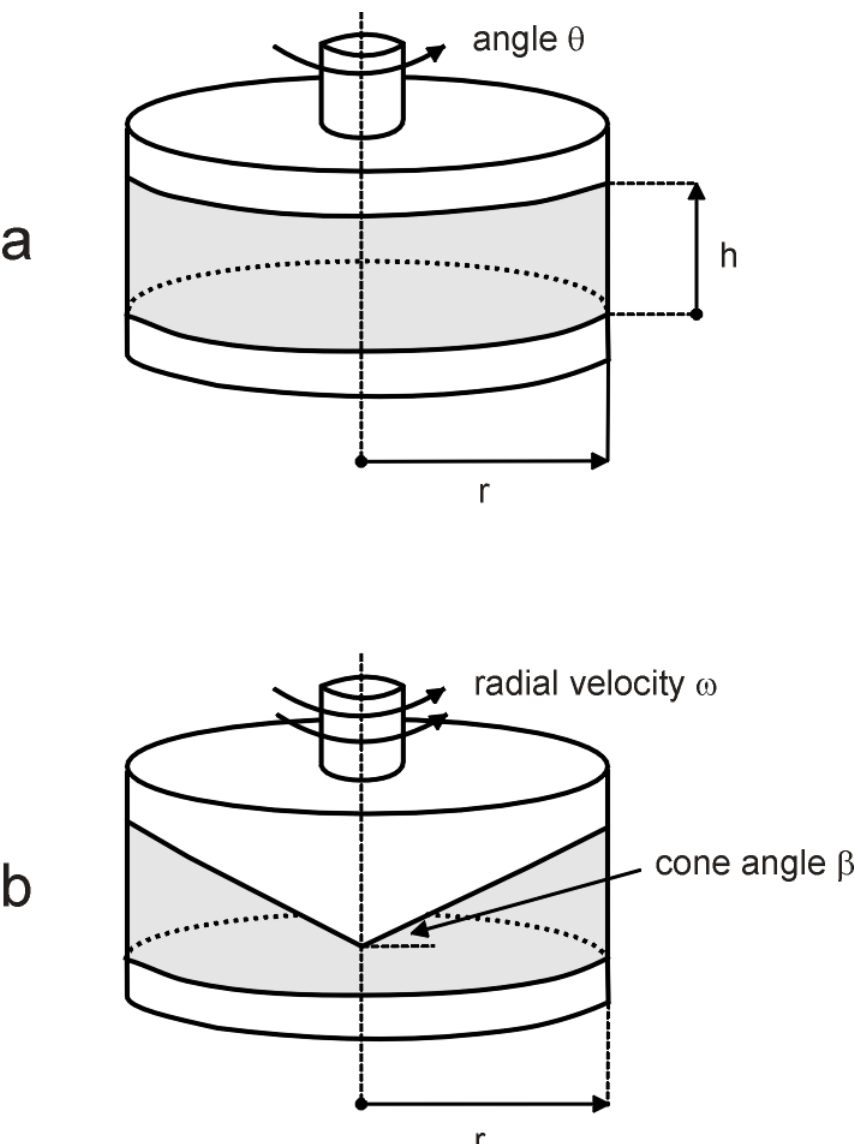
FIGURE 1. Parallel plate and cone/plate geometries.